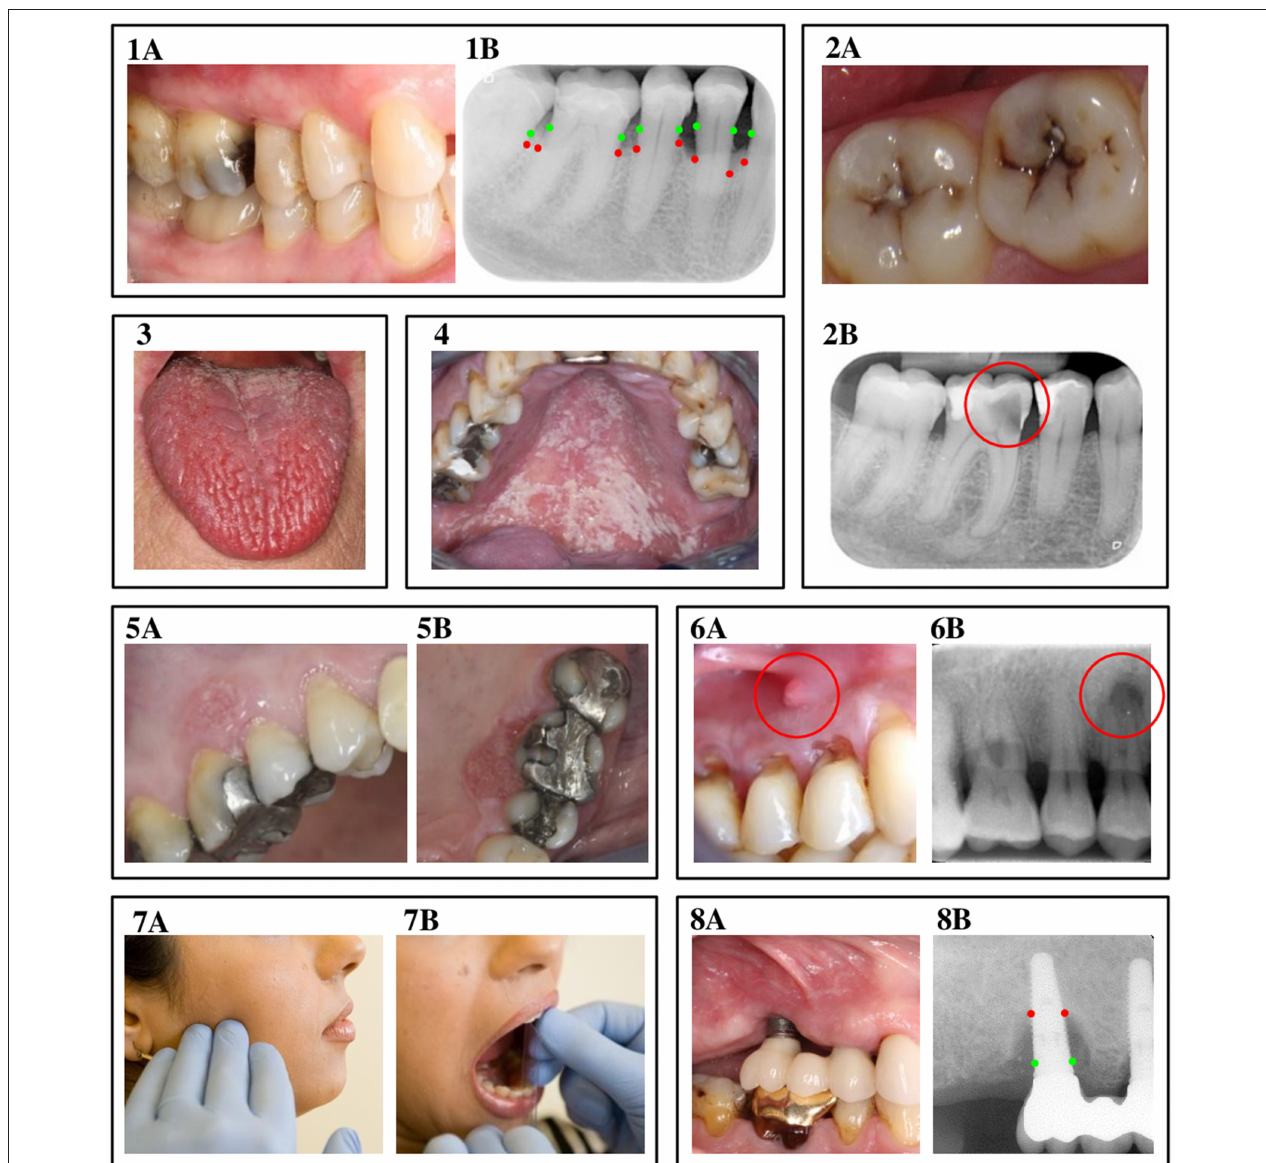
FIGURE 2 | Oral complications of diabetes mellitus. 1A & 1B: Periodontitis. A clinical view of periodontitis is shown in figure 1A, with the corresponding radiograph displayed in image 1B. The green dots in image 1B indicate where the bone level originally was, while the red dots show the actual bone level as a result